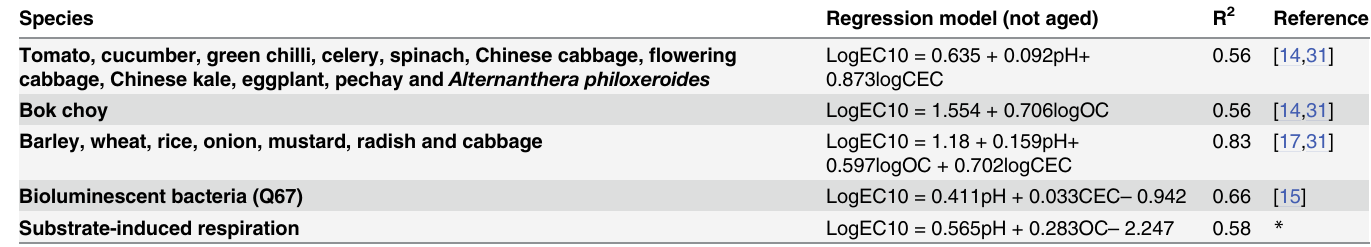
Table 1. Copper ecotoxicity predictive models used for ecotoxicological data normalization.